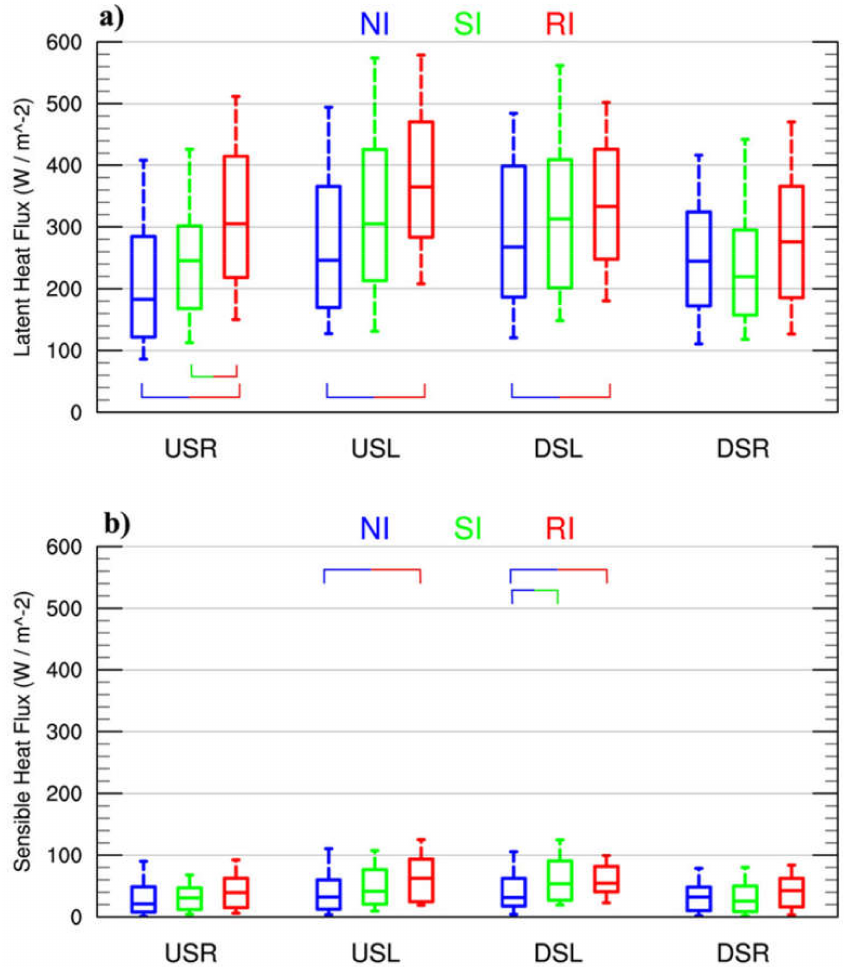
Figure 14. Distributions of surface ( a ) latent heat flux and ( b ) sensible heat flux in non-intensifying (NI; blue), slowly intensifying (SI; green), and rapidly intensifying (RI; red) cases in each shear-relative quadrant. Boxes encompass the 25th, 50th, and 75th percentiles, while whiskers extend to the 10th and 90th percentile values. Brackets denote the differences in the means of the distributions that were significant at the 95% confidence level as determined by a bootstrap test. Adapted from